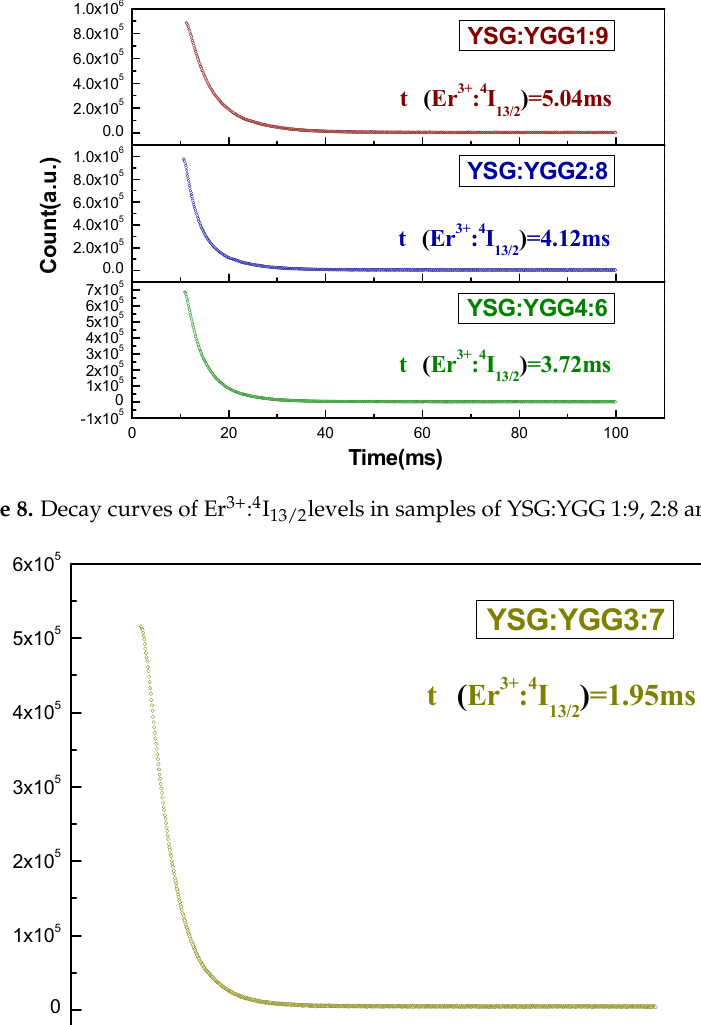
0 Figure 9. Decay curves of Er 3+ : 4 I 11/2 levels in samples of YSG:YGG Figure 9. Decay curves of Er 3+ : 4 I 11/2 levels in samples of YSG:YGG 3:7.